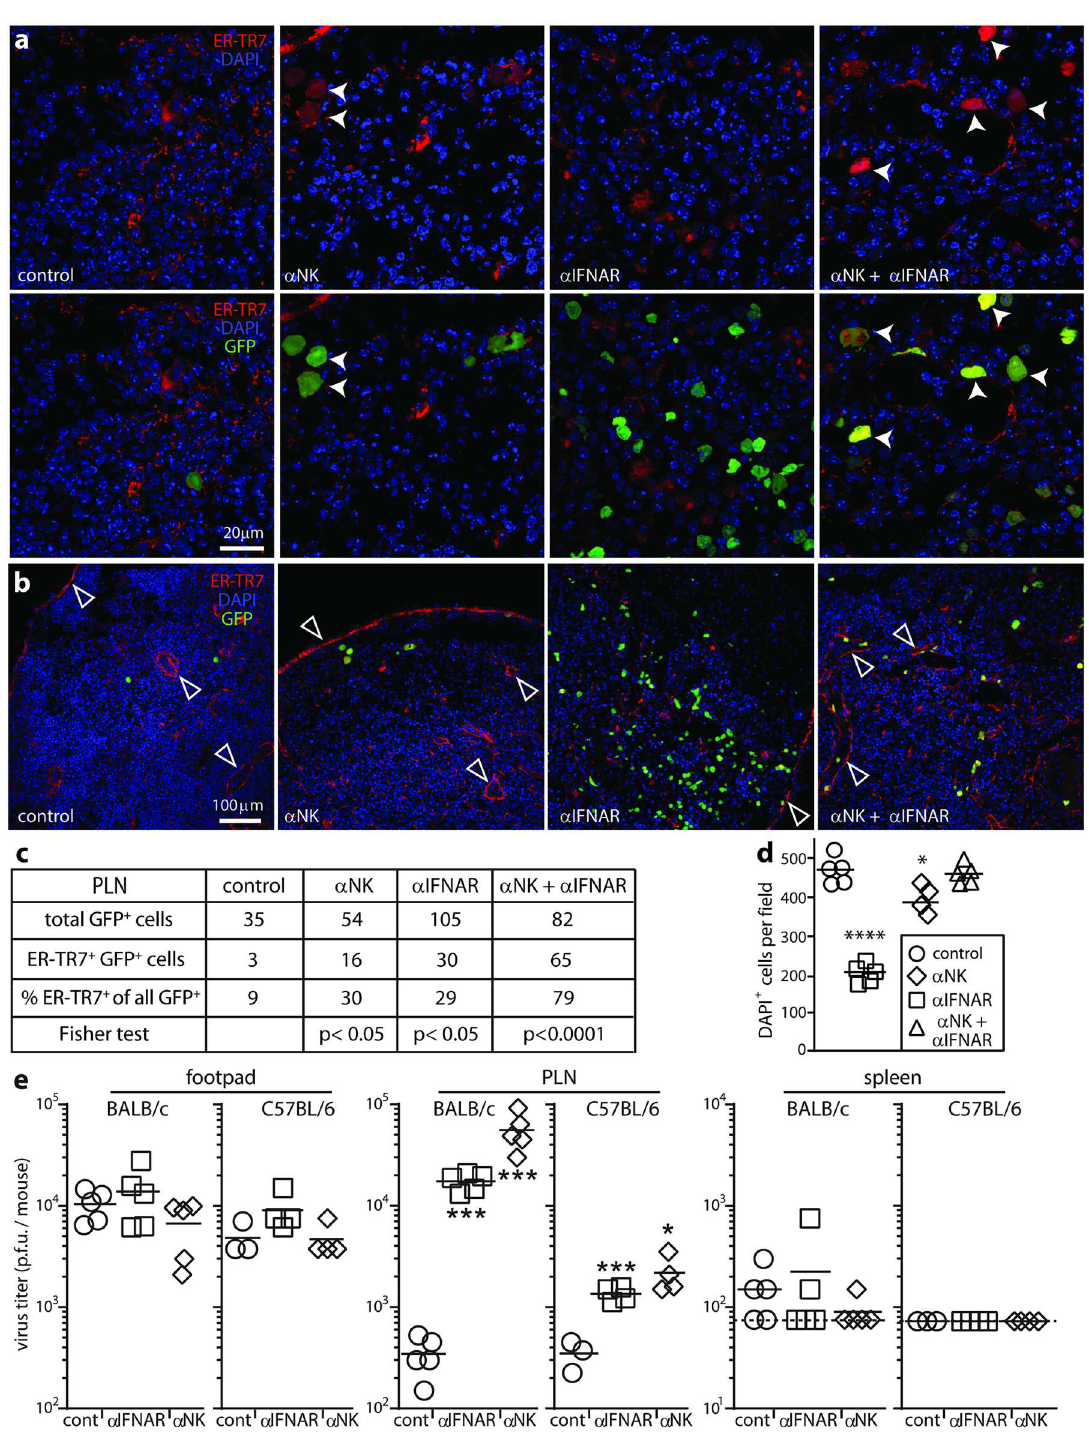
Fig 6. NK cells eliminate ER-TR7 + infected cells and cause tissue damage. (a). C57BL/6 mice were given IFNAR blocking antibody ( α IFN), depletedof NK1.1 + cells ( α NK), given both treatments, or given neither (control). All were then given i.f. MCMV-GR (10 6 p.f.u.). 1 day later PLN sections were stained for viral GFP and the FRC marker ER-TR7. Nuclei were stained with DAPI. Arrows show exampleinfected ER-TR7 + cells, which were abundant after α NK. (b). Low magnification PLN images of mice treated as in (a), but at 3 days post-infection, showingreducedDAPI stainingand altered ER-TR7 staining (arrows) after α IFN, and restorationof these changesby α NK. (c). Counts of infected cells as shown in a , summing across 6 fields